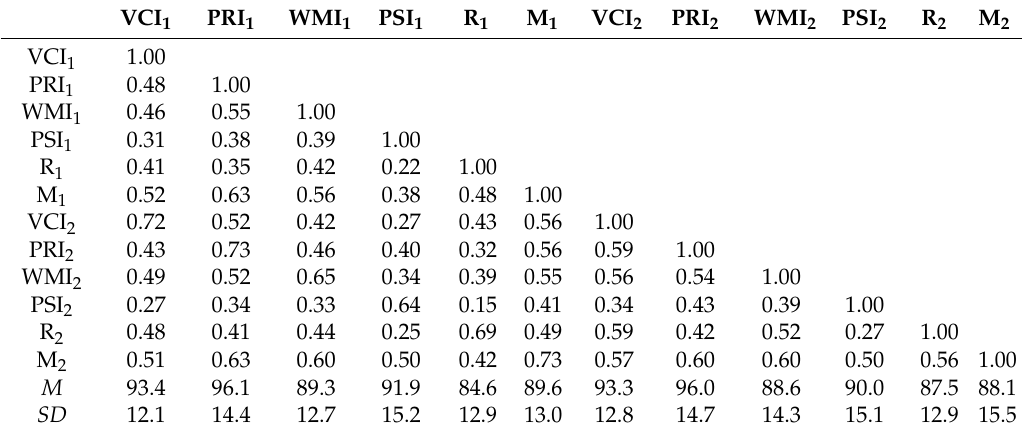
Table 1. Correlations and Descriptive Statistics for WISC-IV Index Scores and Reading